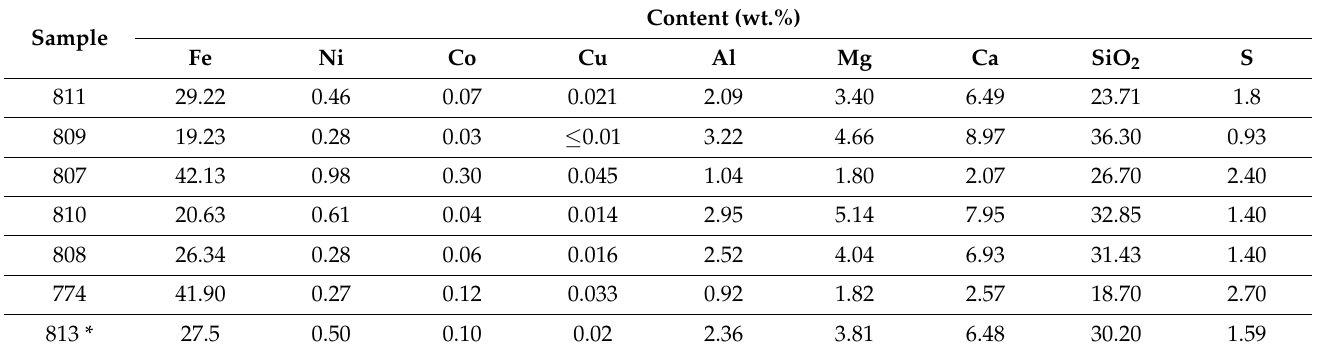
Table 1. The chemical composition of slag samples from different points of the slag